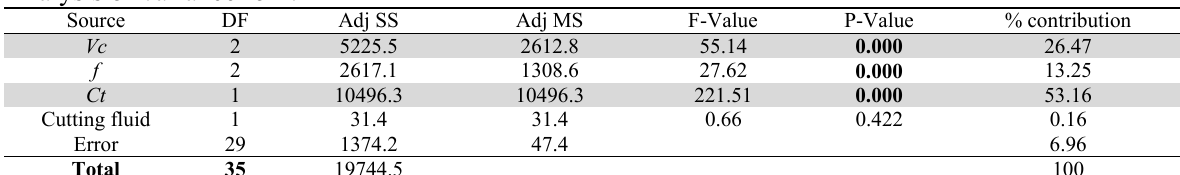
Analysis of variance for VB Source